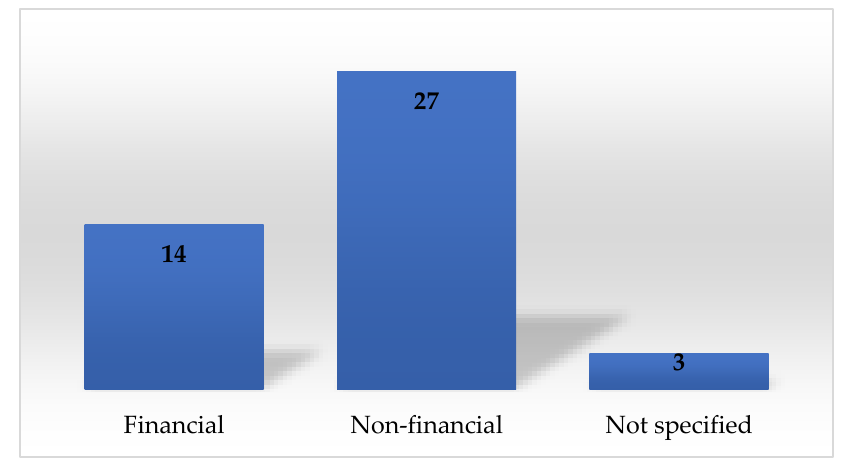
Figure 5. Type of performance investigated